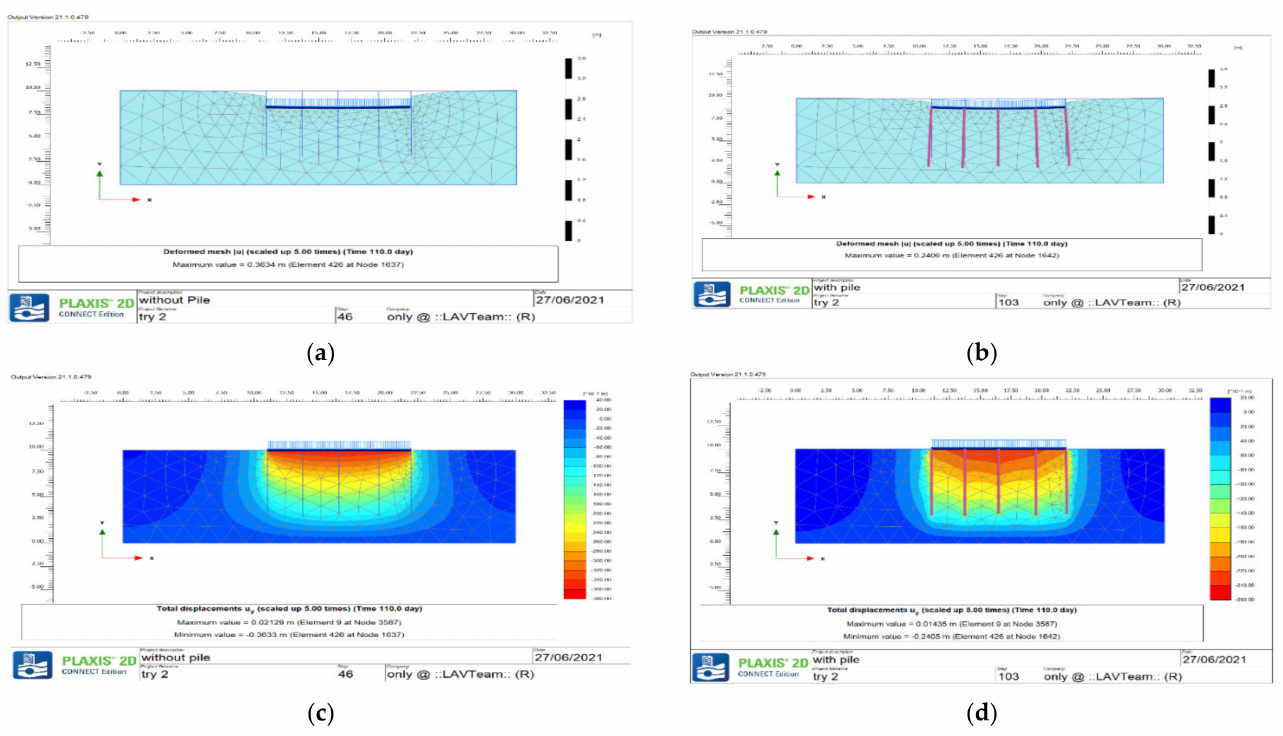
Figure 9. 500 kN/m 2 load, raft and pile raft: ( a ) deformed mesh of raft, ( b ) contours of displacement raft, ( c ) deformed mesh piled raft, and ( d ) contours of displacement piled